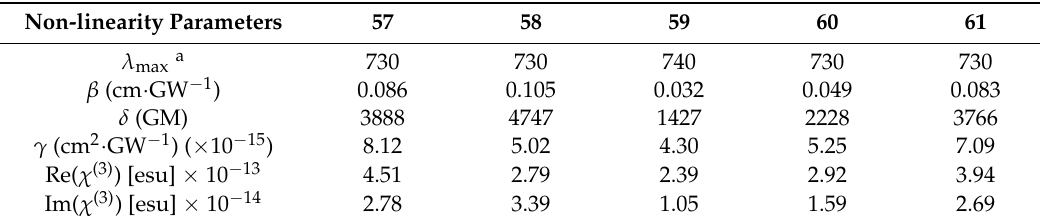
Table 6. Open- and closed-aperture Z-scan measurement data for the third-order nonlinear parameters of 57 – 61